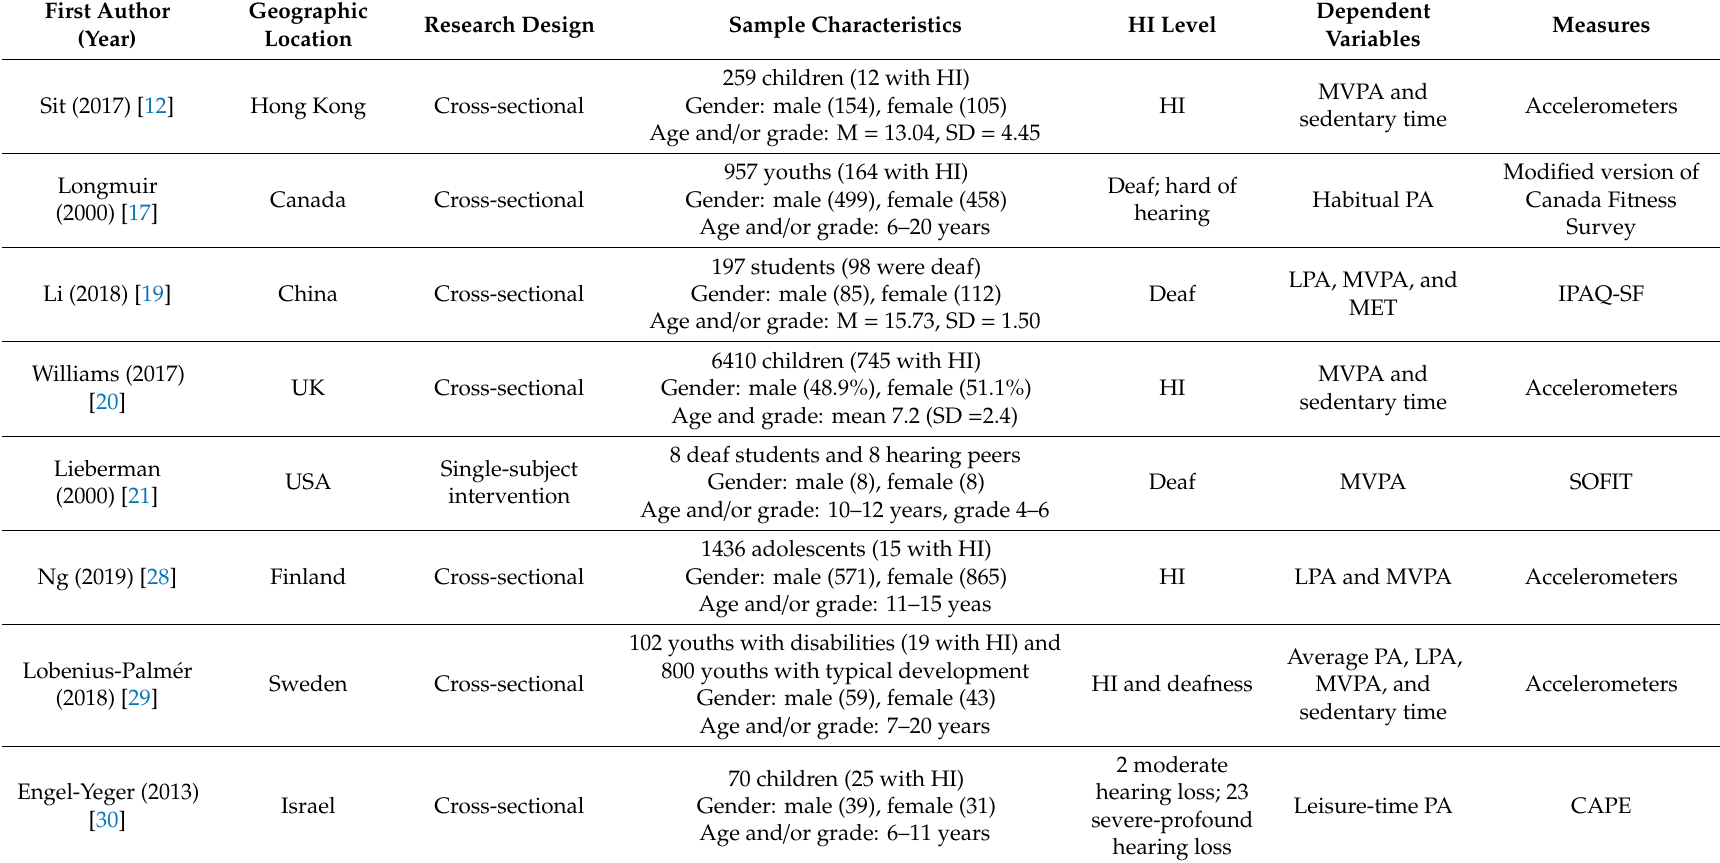
Table 2. Study characteristics of included